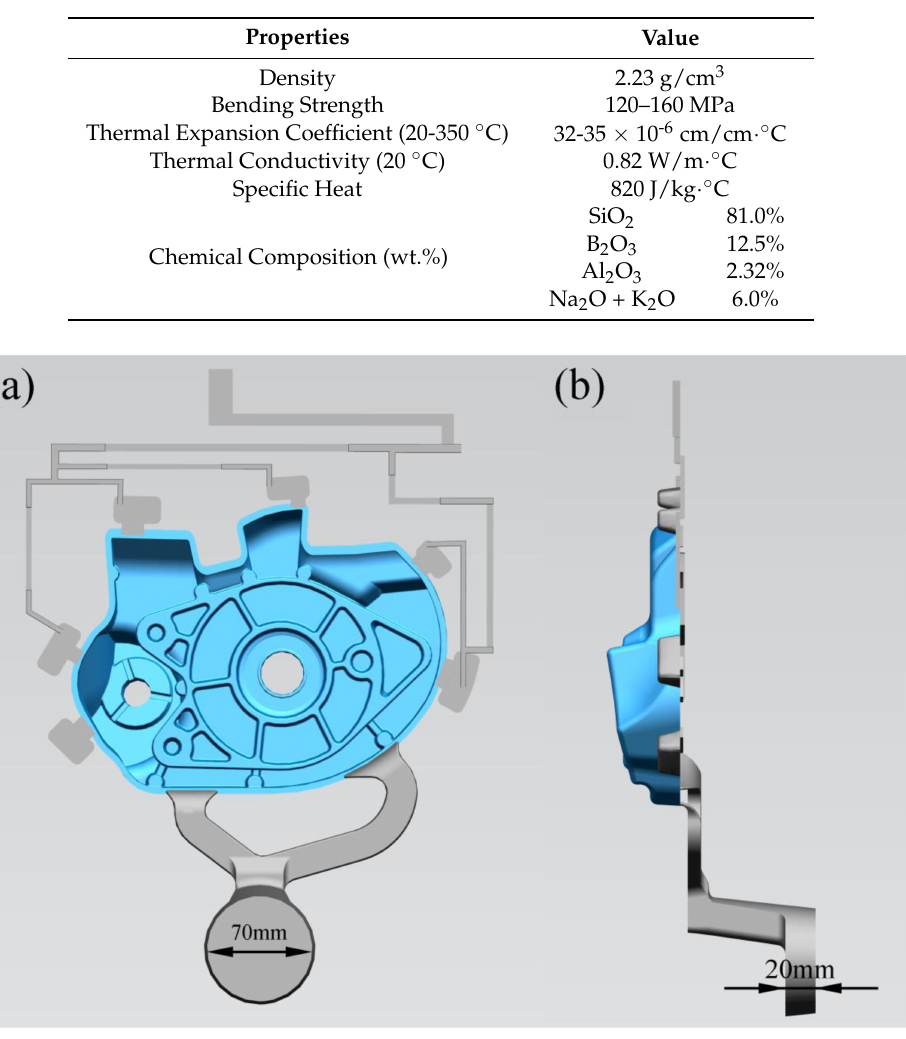
Figure 1. Geometry of die castings for the flow visualization